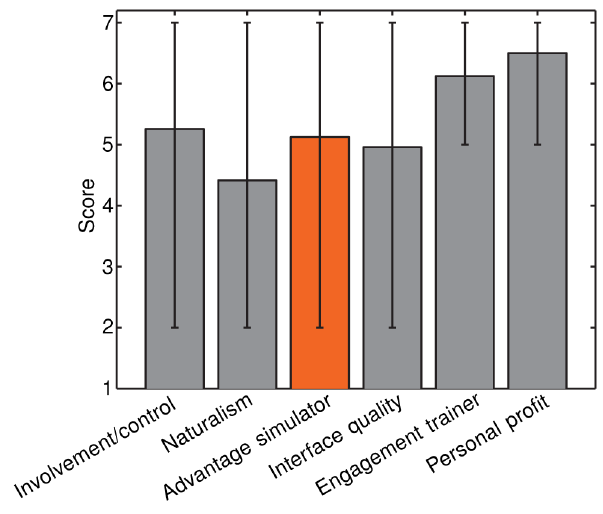
Figure 15. Results of the participants questionnaire on different categories of questions. Grey and orange bars indicate the mean value over all questions for a certain category. Bars in orange indicate questions that were only asked in the simulator group. The small bars indicate the range of scores (minimal to maximal).